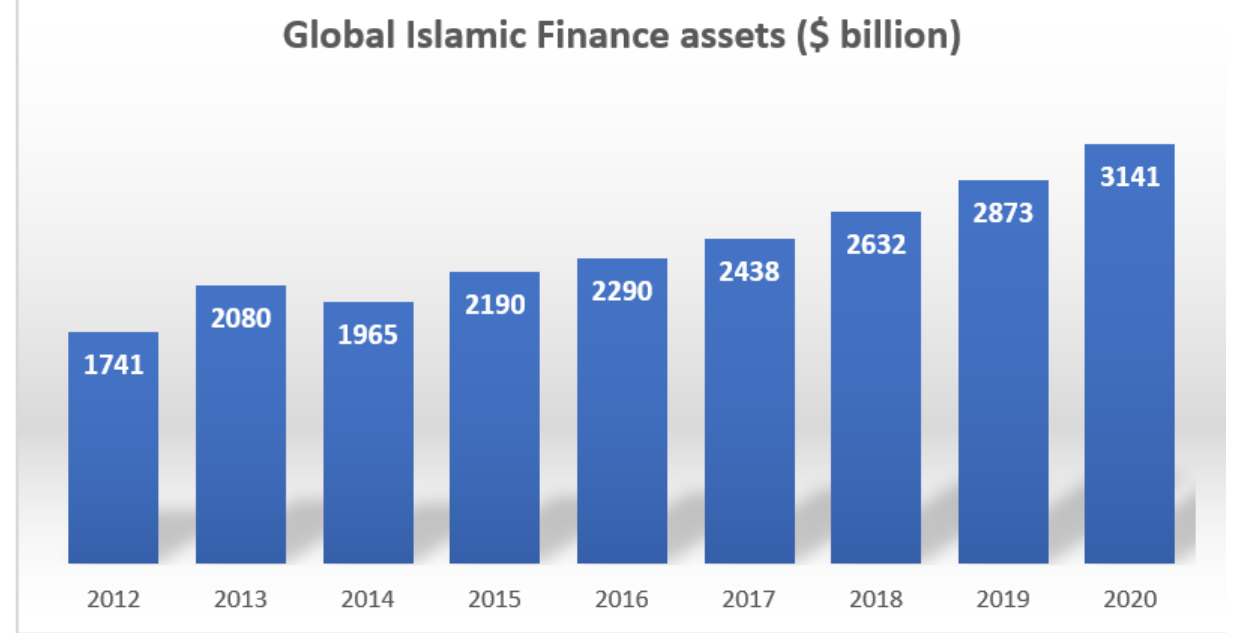
Figure 1. Global Islamic Finance assets ($ billion) Source: World Bank report 2020 [61].